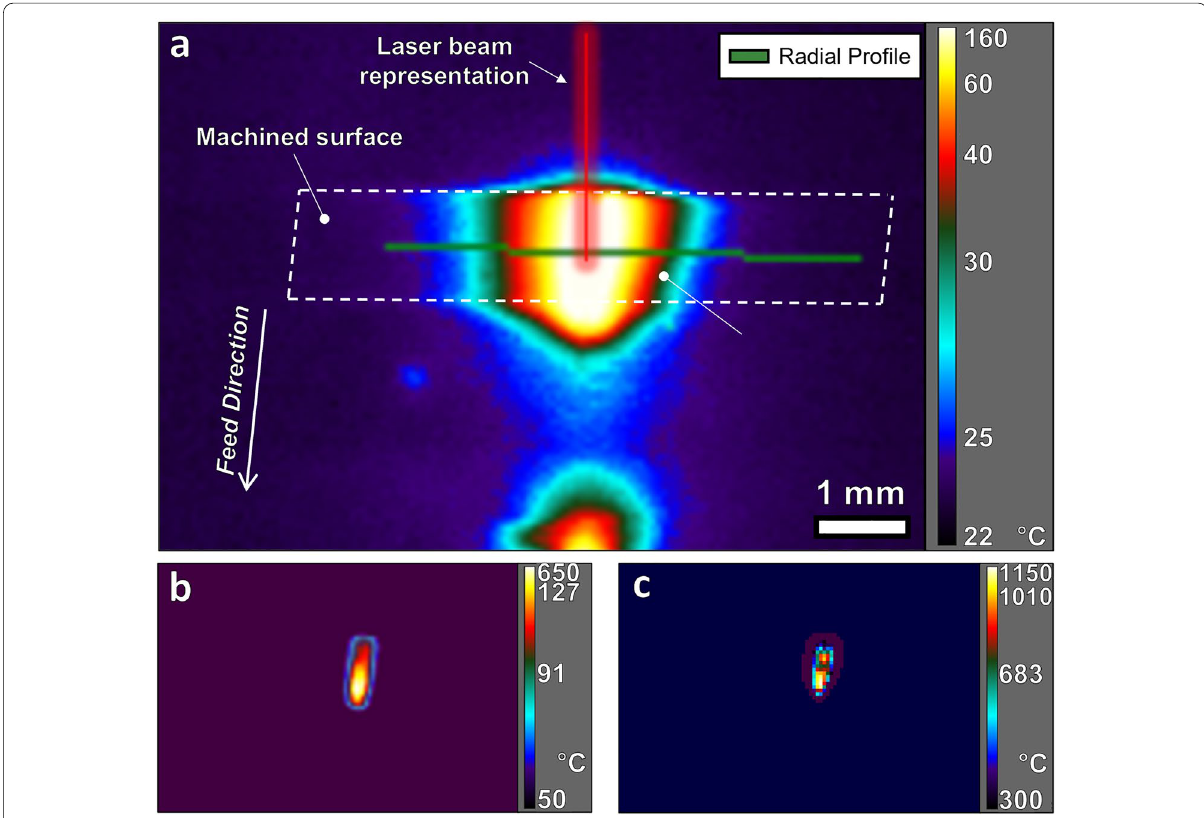
Figure 3 Schematic overview of thermal imaging methodology: the schematic depicts the experimental methods used to investigate the thermal properties in the surface of the bone sample during laser machining. The radial profile is used for both the spatial and temporal plots. It should be noted that the colour bar is non‑linear and uses plateau equalisation to improve the contrast for the entire scene. As there is not one camera calibration profile to cover the complete temperature range, three recordings were used: ( a ) low‑range, ( b ) mid‑range, ( c ) high range